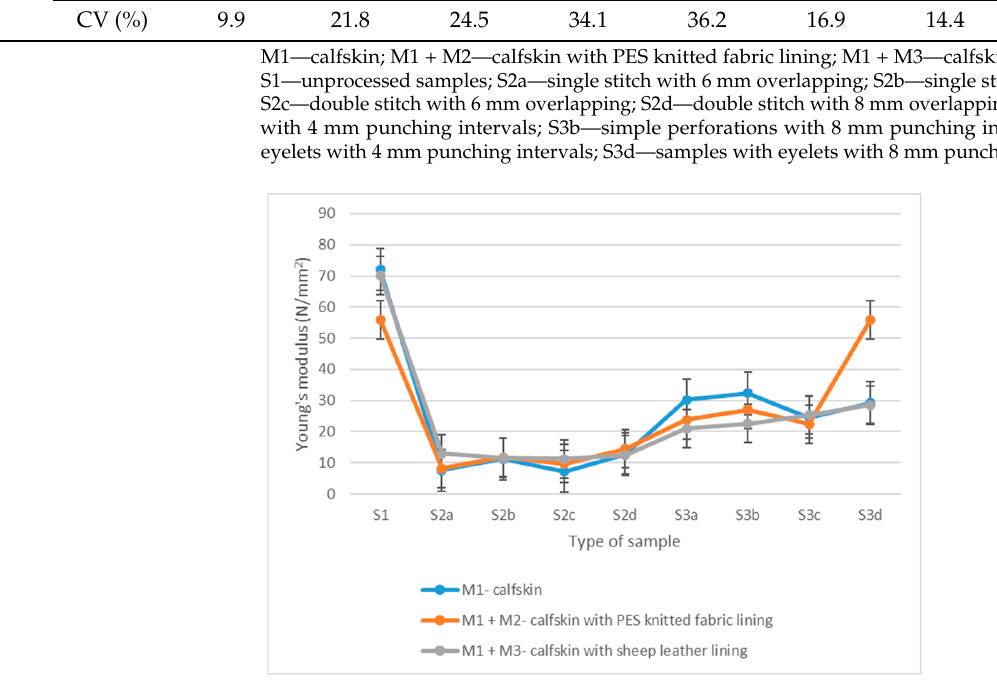
Figure 4. Young’s modulus mean values distribution.